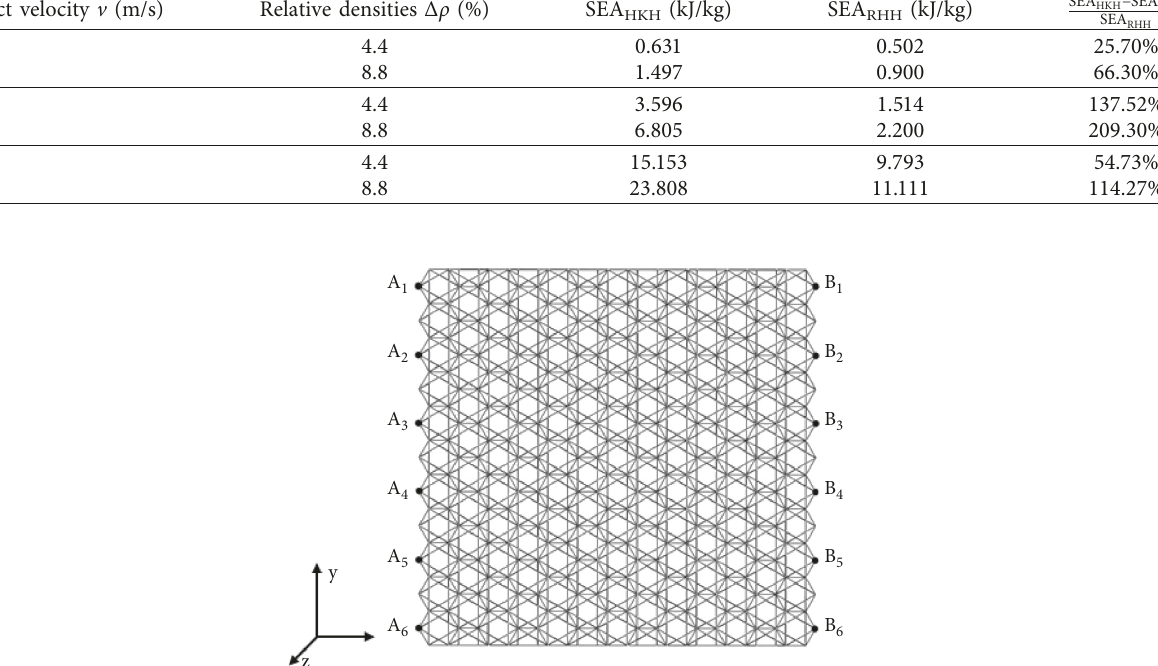
Table 2: SEA values of RHH and HKH with different impact velocities and relative densities. Impact velocity v (m/s) Relative densities Δ ρ